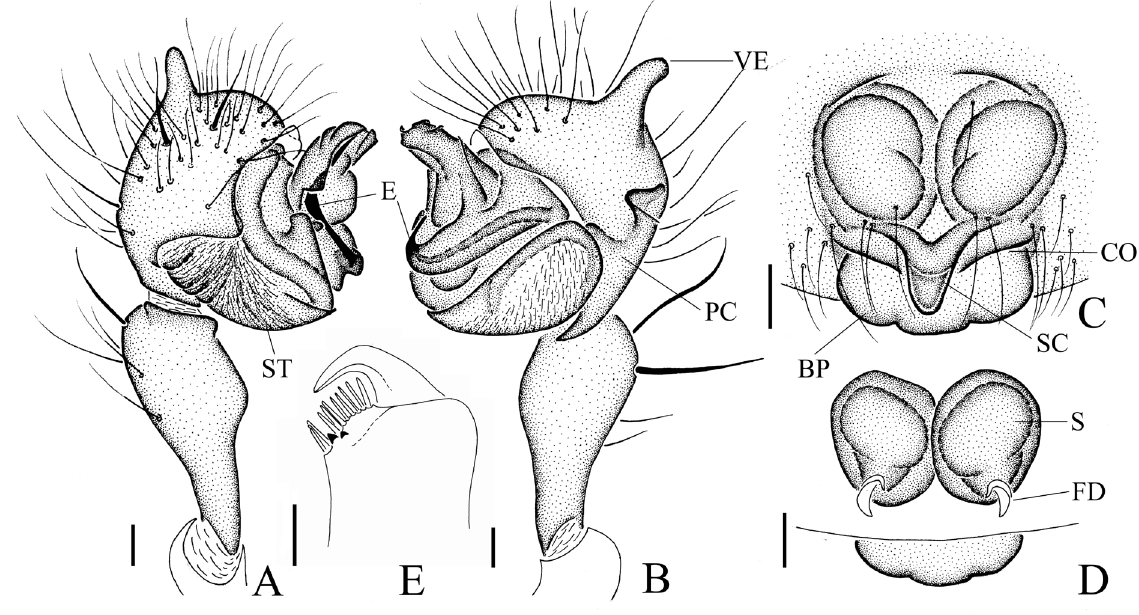
Fig. 4. Mimetus lingbaoshanensis sp. nov. A – B , E . Holotype, ♂ (YN-MIM-2015-010). C – D . Paratype, ♀ (YN-MIM-2015-011). A . Palp, prolateral view. B . Palp, retrolateral view. C . Epigyne, ventral view. D . Vulva, dorsal view. E . Left chelicerae, ventral view. Scale bars = 0.1